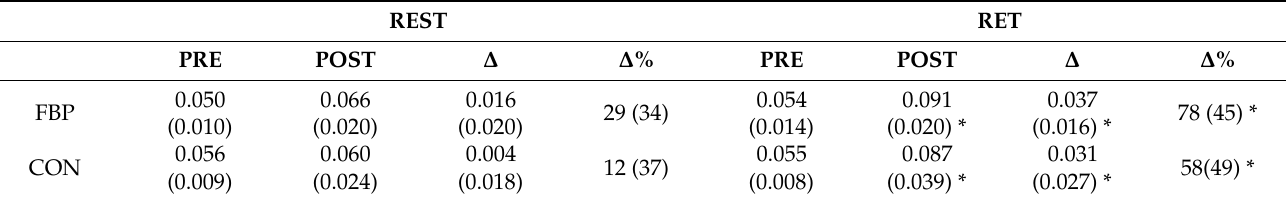
Table 3. Myofibrillar fractional synthetic